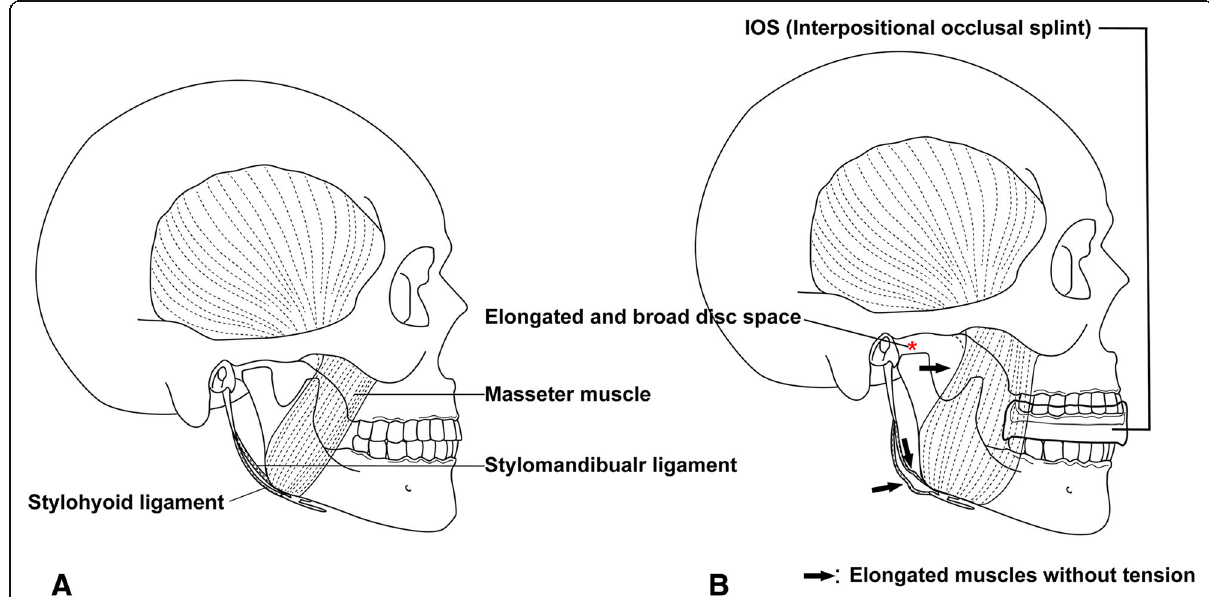
Fig. 7 Schematic drawings of the basic actions of the interocclusal splint showing a tight articular disc space with the involved muscles without an IOS ( a ) and a loosened articular space with elongated or released muscles in IOS application ( b